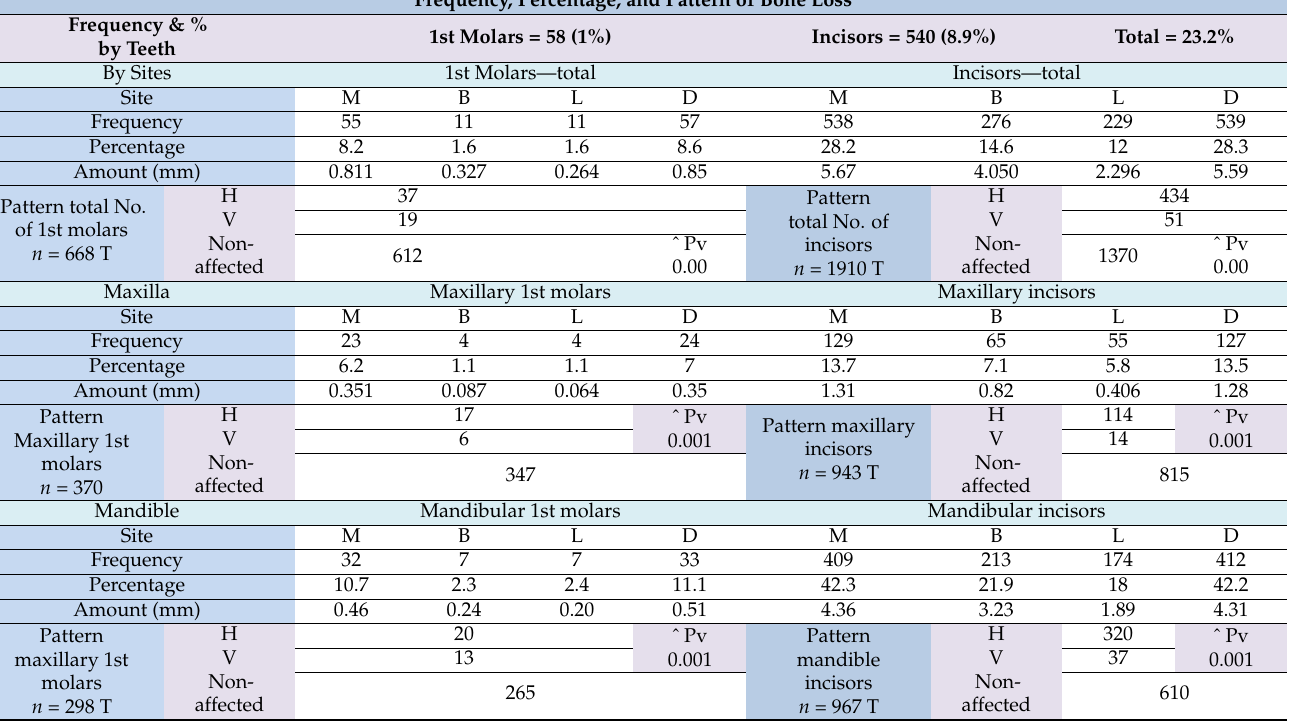
Table 2. Site distribution, frequency, percentage, and total amount of bone loss in mm revealed around maxillary and mandibular 1st molars and incisors and patterns of bone loss among sites of these two groups of teeth in the upper and lower